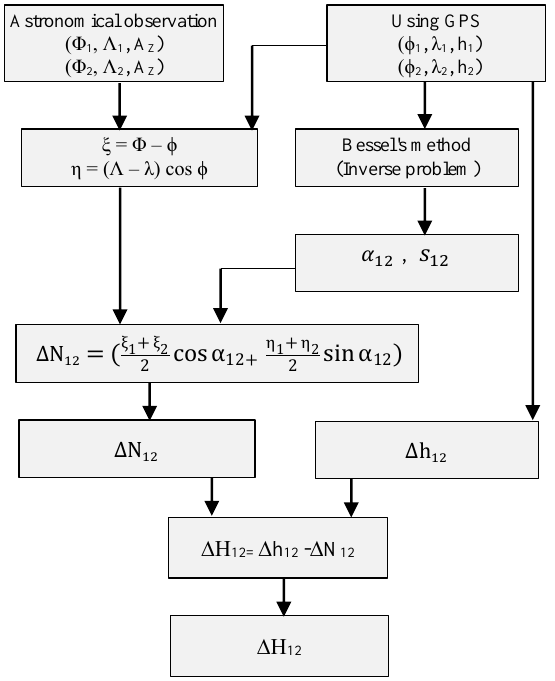
Diagram 1. Basic principle of ∆H